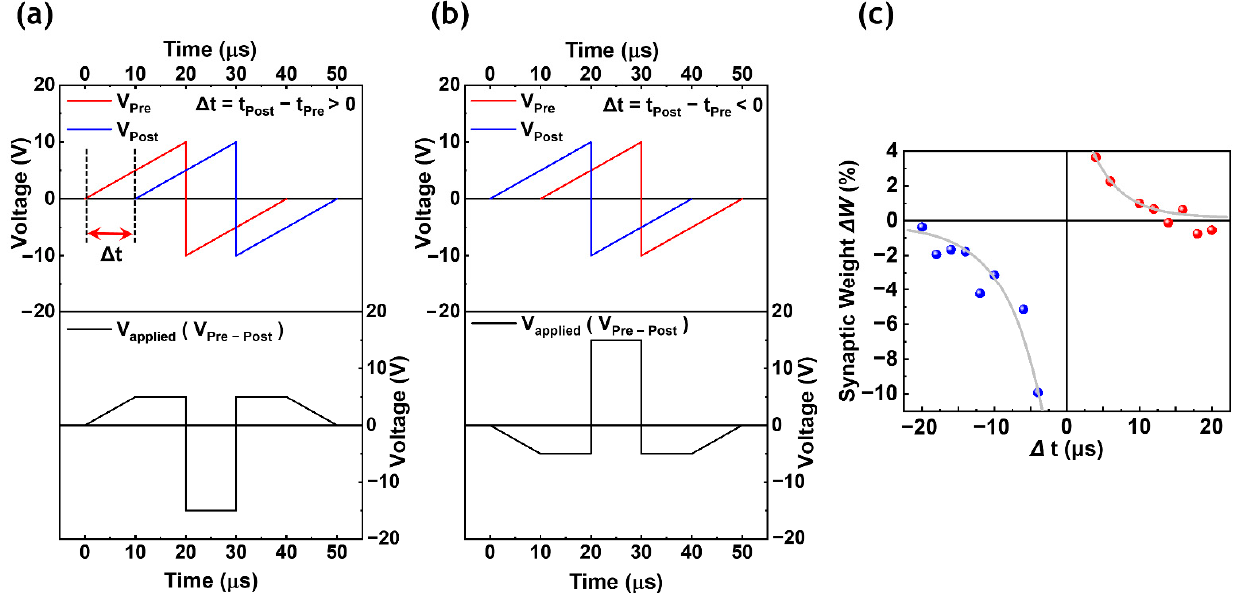
Figure 5. Spike-timing-dependent plasticity (STDP) with synaptic weight change according to time dependence. ( a , b ) Ap- plied pulses (V applied = V pre − V post ) calculated from the pre- and post-synaptic neuron spikes at different times ( ∆ t). ( c ) STDP measurement with fitting curves.